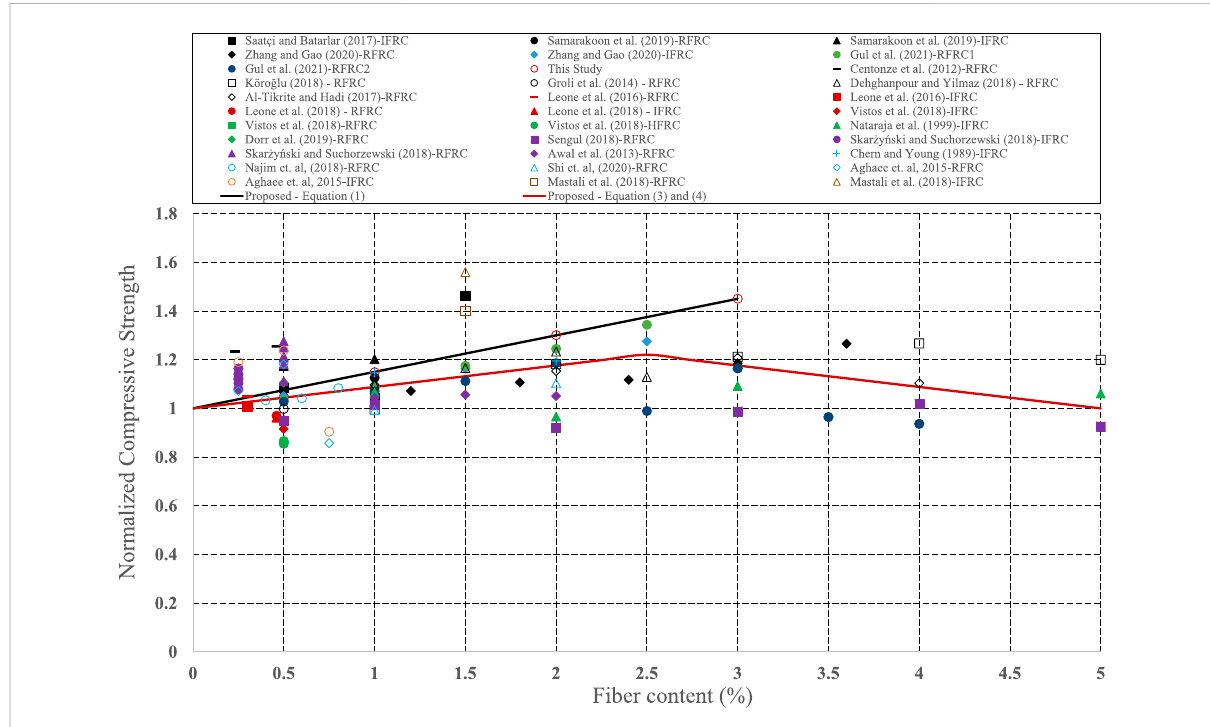
FIGURE 11 Variation of the normalized compressive strength of the steel fi ber reinforced concrete with the fi ber content.